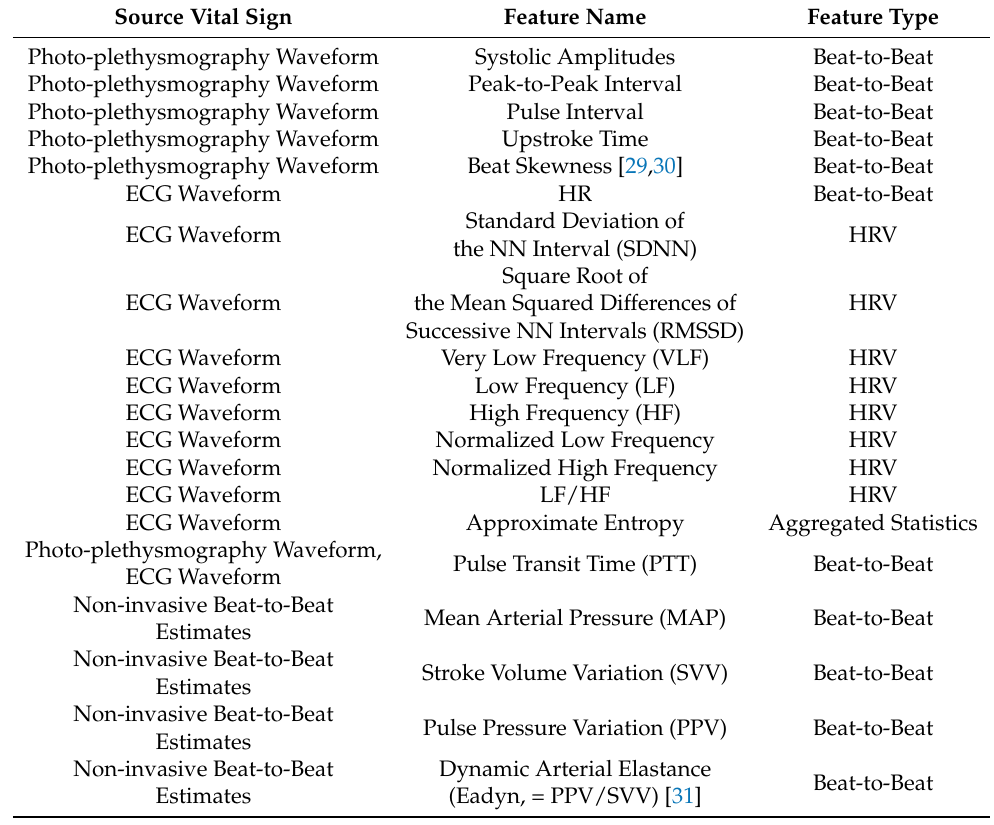
Table A2. The features derived from non-invasive vital